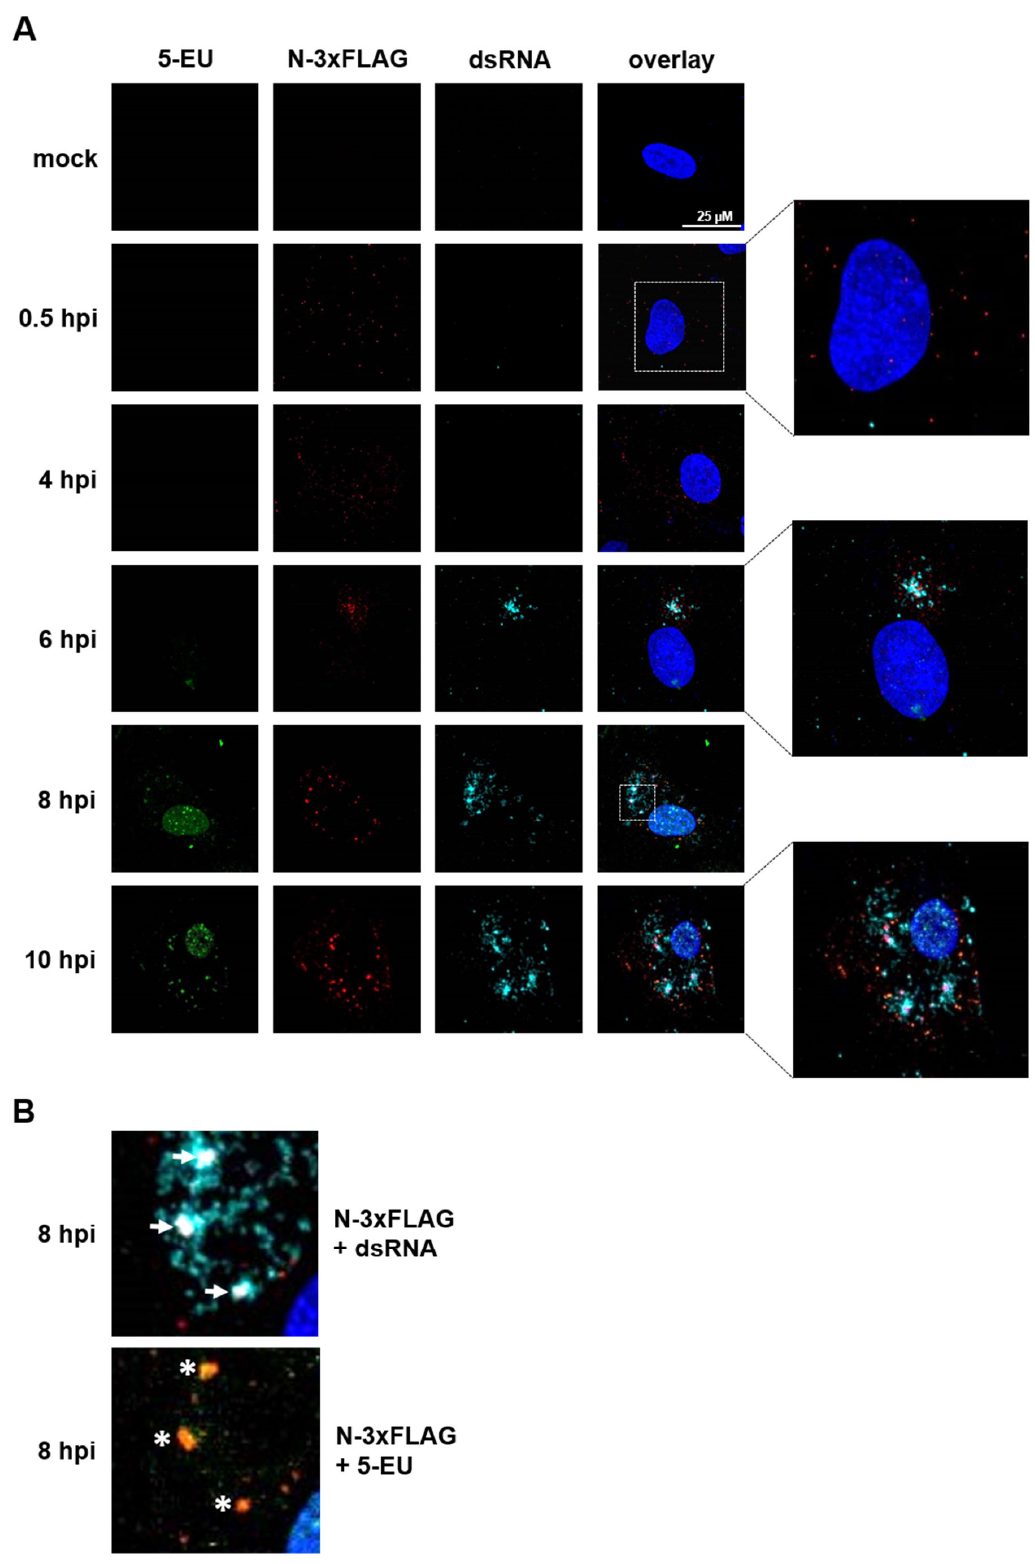
Figure 5. Visualization of the incoming SARS-CoV-2 nucleocapsids and newly synthesized viral RNA. ( A , B ) Vero E6 cells were infected with a recSARS-CoV-2 marker virus expressing a 3x-FLAG-tagged nucleoprotein (N-3xFLAG) under high MOI conditions (MOI~5). After one hour, the virus inoculum was replaced by a cell culture medium containing 20- µ g/mL actinomycin D to inhibit cellular transcription. One hour later, 5-ethynyl uridine (5-EU) at a final concentration of 1